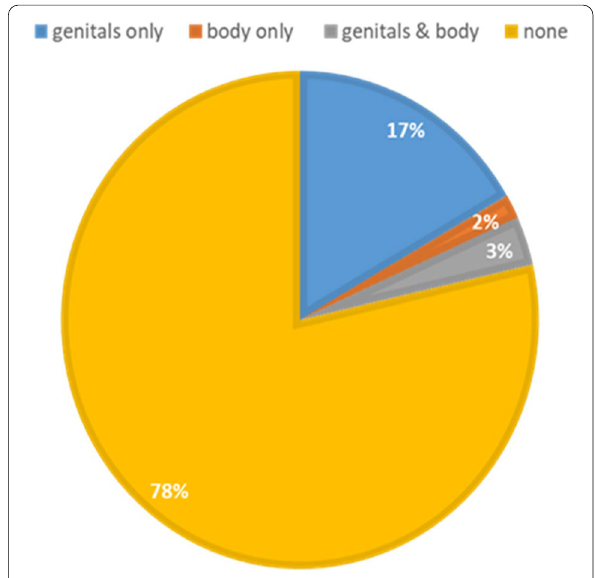
Fig. 1 Physical injuries sustained by victims